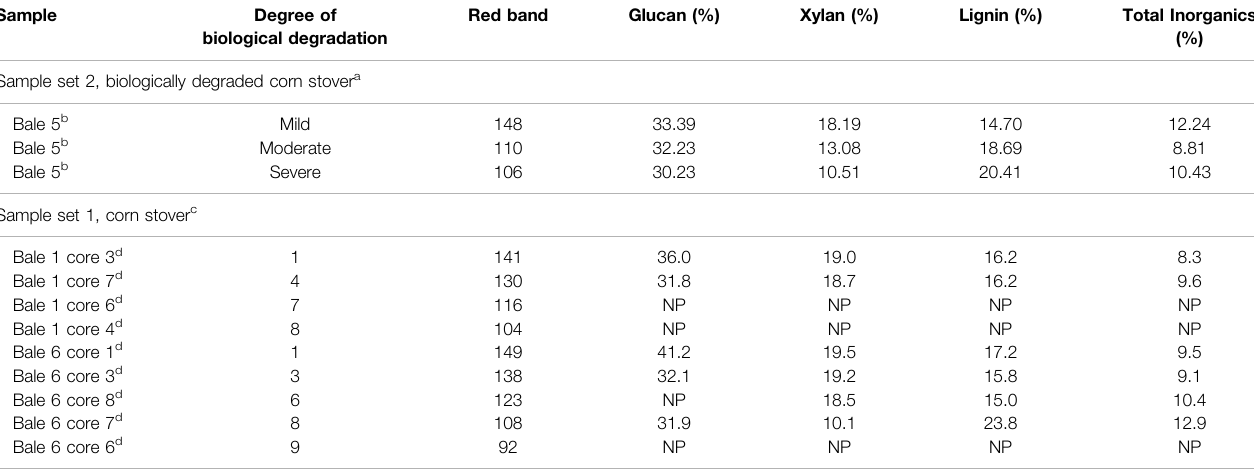
TABLE 2 | Biological degradation properties, red band value, and chemical composition of corn stover for samples characterized using FT-IR. Sample